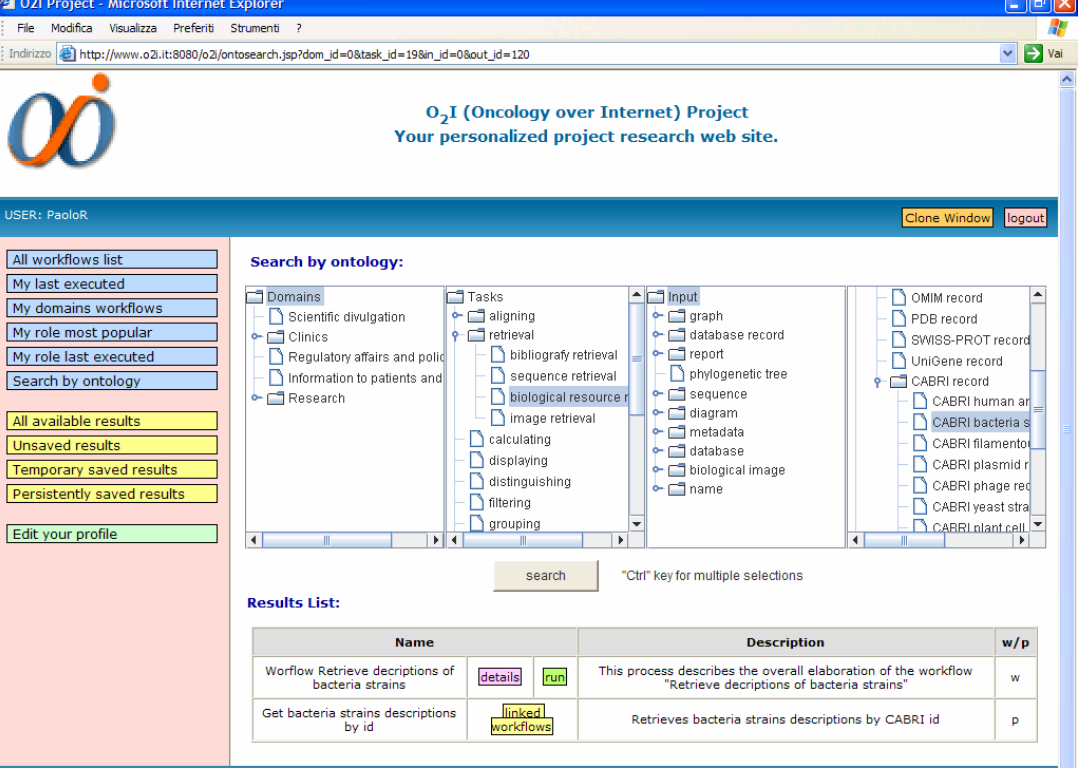
Figure 3: web page allowing search of workflows through their annotation and a list of results. Conditions were put on task (biological resources retrieval) and output (CABRI bacteria record)